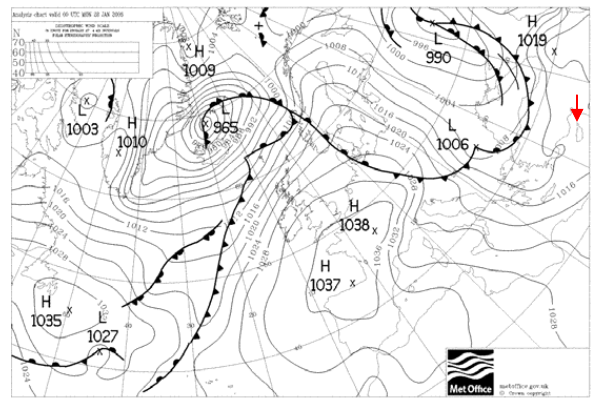
Fig. 1. Surface analysis chart for 0000 UTC 28 January 2008 (U.K., Met. Office). The red arrow points to Cyprus area.